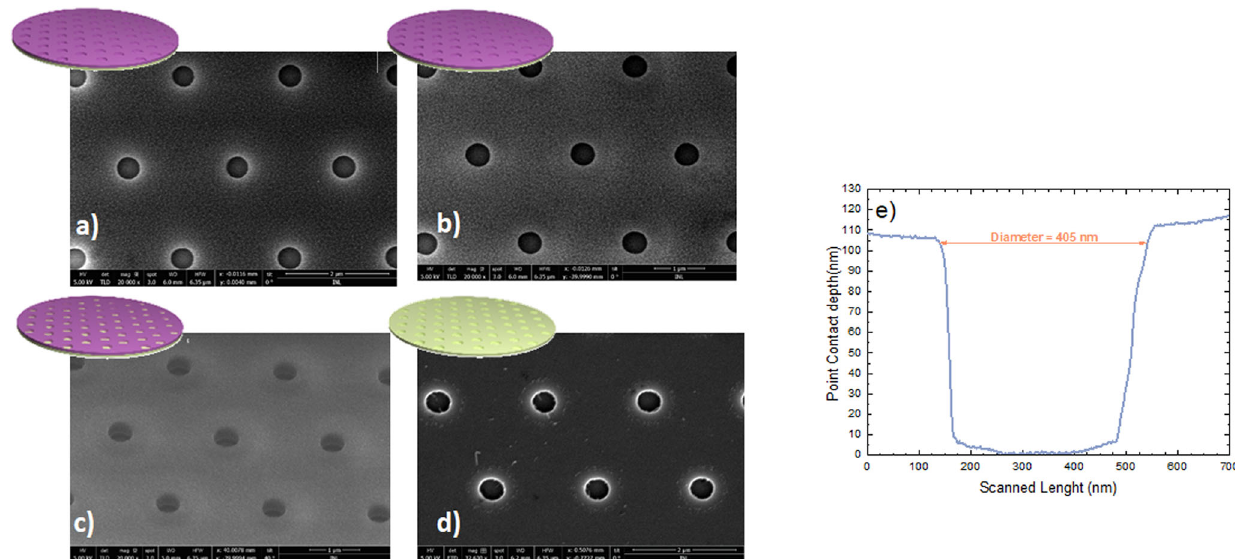
Fig. 2 Characterization of the NIL process on the 200 mm point contact stamp. Top view SEM images of the 200 mm point contact stamp ( a ) and ( b ) after the NIL process, ( c ) after the Si etching, and ( d ) After the resist removal and wafer cleaning. e AFM cross-section pro fi le of one point contact of the Si stamp.